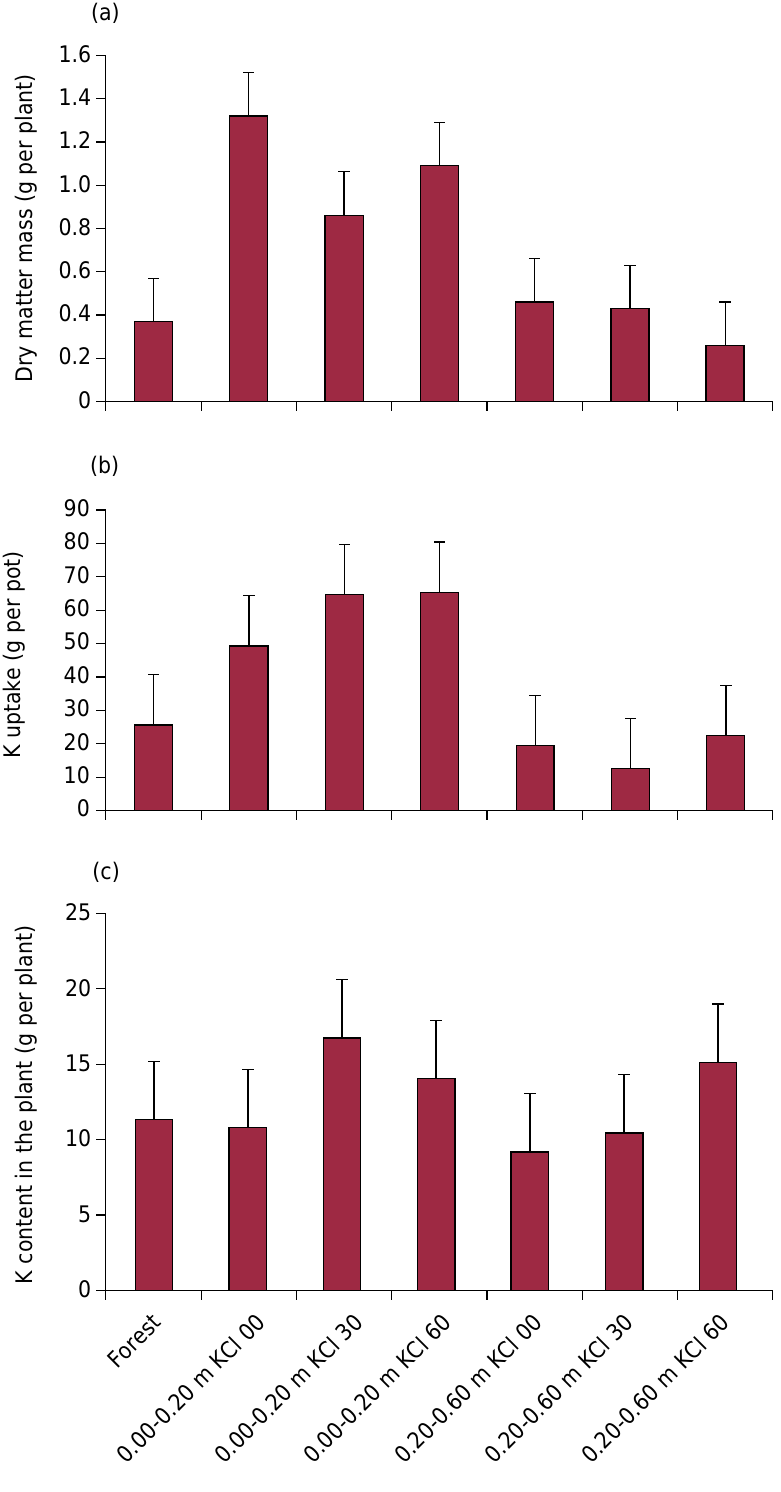
Figure 4. Dry matter yields (a), plant K content (b), and K uptake by Urochloa ruziziensis (c). Vertical bars show the least significant difference